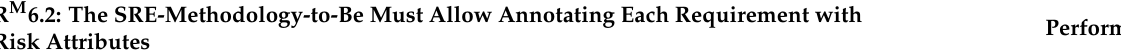
Table 5. Verification method for R M